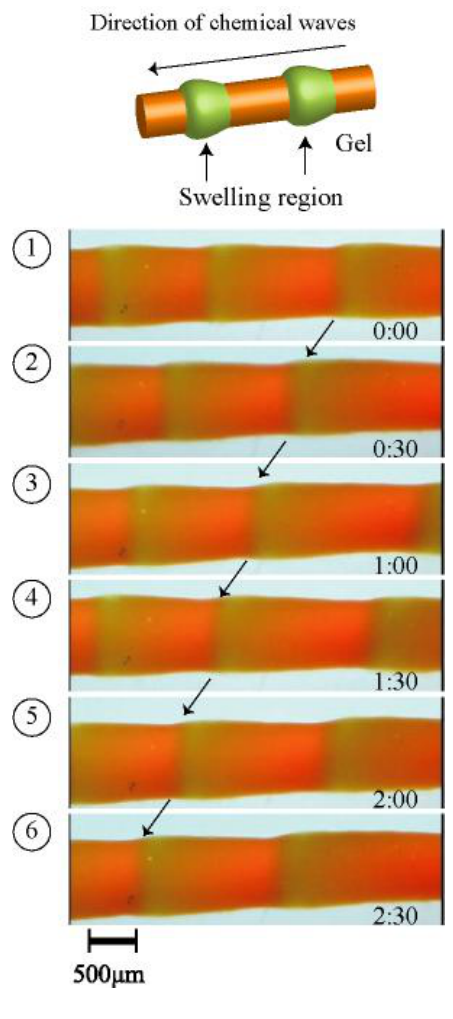
Figure 6. Time course of peristaltic motion of microphase-separated self-oscillating gel in 8 mL of the mixture solution of the BZ substrates (62.5 mM malonic acid, 84 mM sodium bromate, 0.894 M nitric acid, 18 °C). The green and orange colors correspond to the oxidized and reduced state of Ru moiety in the gel, respectively. S. Maeda et al. Peristaltic motion of polymer gels. Angew. Chem. Int. Ed. 2008 , 47 , 6690-6693. Copyright Wiley-VCH Verlag GmbH & Co.KGaA. Reproduced with